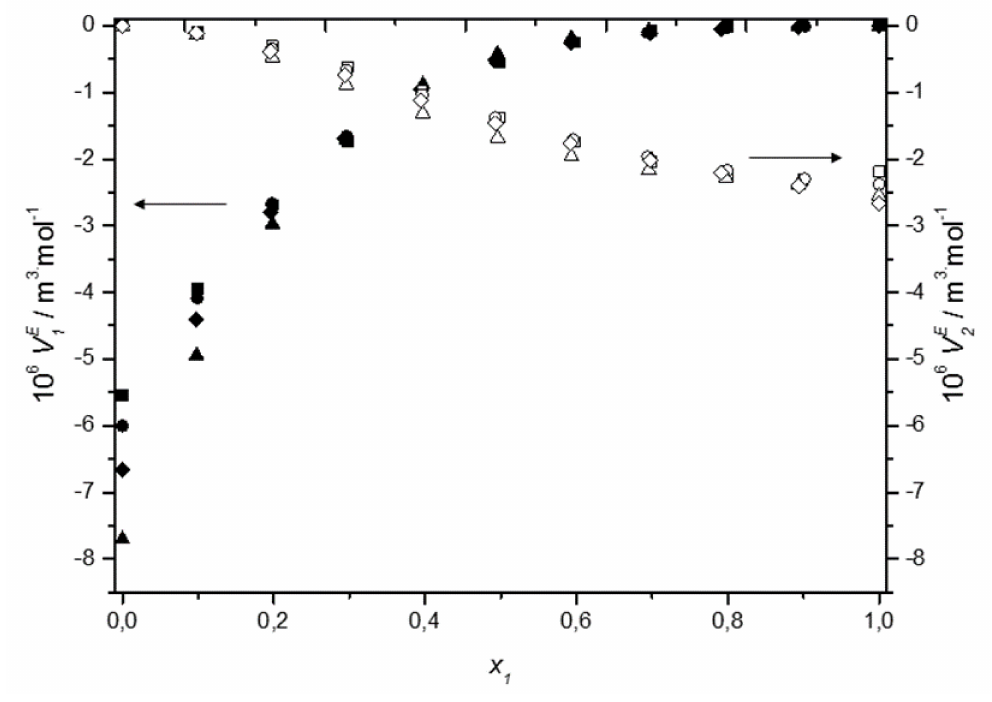
Figure 6. Dependence of the excess partial molar volume V E 1 of (cid:4) DES1, • DES2, (cid:78) DES3, (cid:7) DES4, E (cid:3) DES1, and water V DES2, (cid:52) DES3, ♦ DES4 on molar fraction of deep eutectic solvent at 2 in (cid:35) 298.15